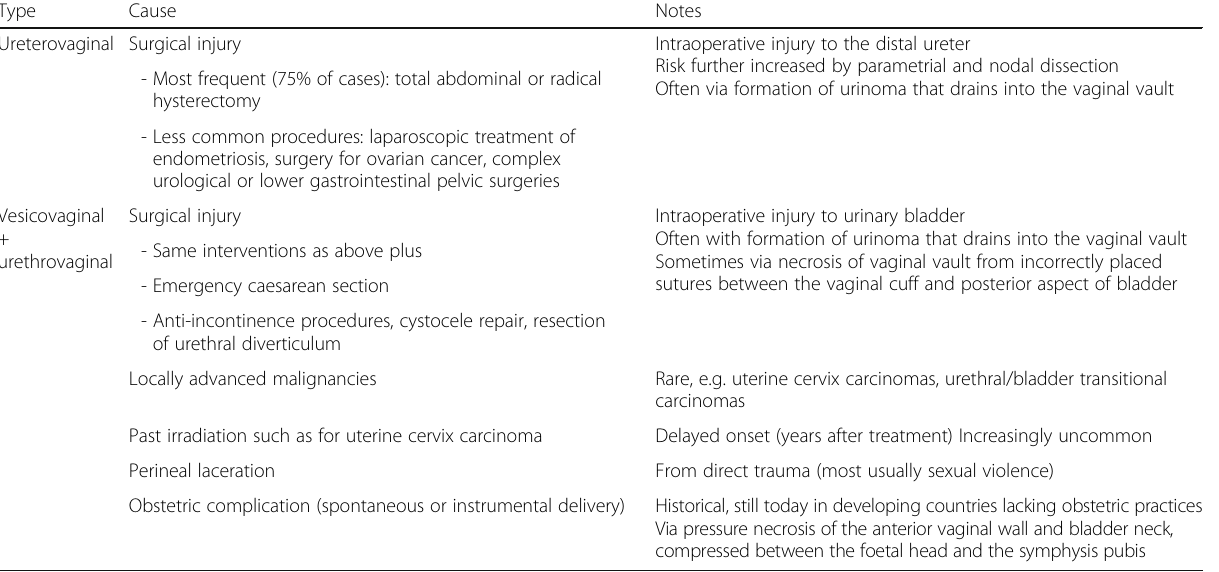
Table 2 Categorisation, causes and mechanisms of urinary vaginal fistulas Type